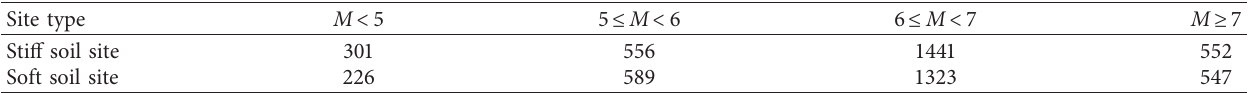
Table 3: Classification results of ground motion records based on earthquake